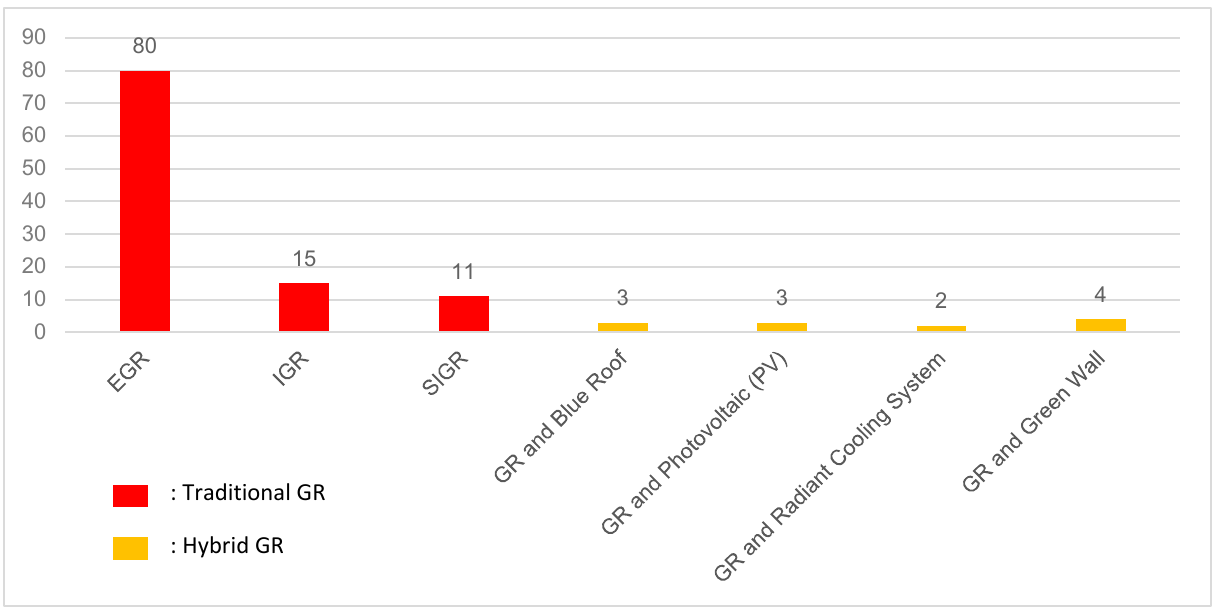
Figure 3. Distribution of papers across each type of GR (EGR: extensive green roof, IGR: intensive green roof, and SIGR: semi-intensive green roof).